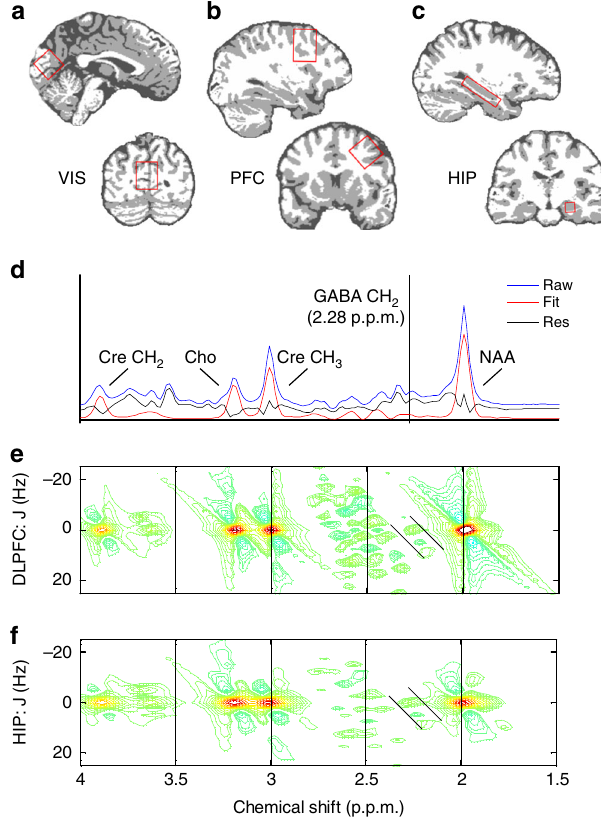
Fig. 2 1 H MRS quanti fi cation of GABA concentrations. a – c Positions of the visual cortical, DLPFC, and hippocampus (HIP) voxels are displayed on sagittal (top row) and coronal (bottom row) slices extracted from an example subject ’ s tissue segmented structural scan. d An example of the 1 H MRS spectra displayed in one dimension. Blue line: raw metabolite spectra for an example subject. Red line: ProFit basis functions for singlet (one- peak) metabolites, including Creatine (Cre), Choline (Cho), and N-acetyl aspartate (NAA). Black line: residuals after fi tting. Note the GABA CH 2 methylene group at 2.28 PPM is invisible on the 1D plot. e and f Plotted for the DLPFC ( N = 23) and HIP ( N = 18) voxels are the fi tted spectra (averaged overall subjects) of the same four metabolites, but now spread along two dimensions, the J-resolved axis ( ± 20 Hz) plotted and the chemical shift axis (1.5 – 4 parts per million; p.p.m.). Both plots use identical scaling. Colors indicate minimum (blue) and maximum (red) height of spectral contours (arbitrary units). The GABA CH 2 methylene group is visible at 2.28 p.p.m. (diagonal